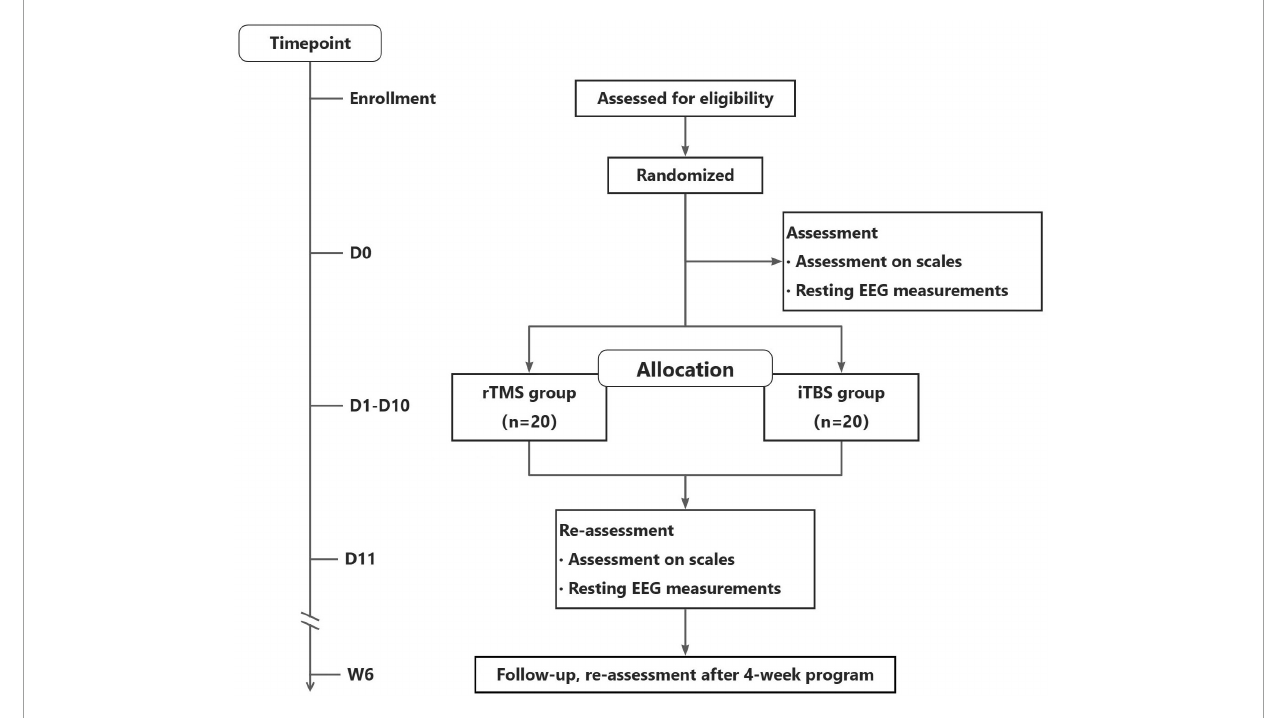
FIGURE1 Design and flow of participants through the